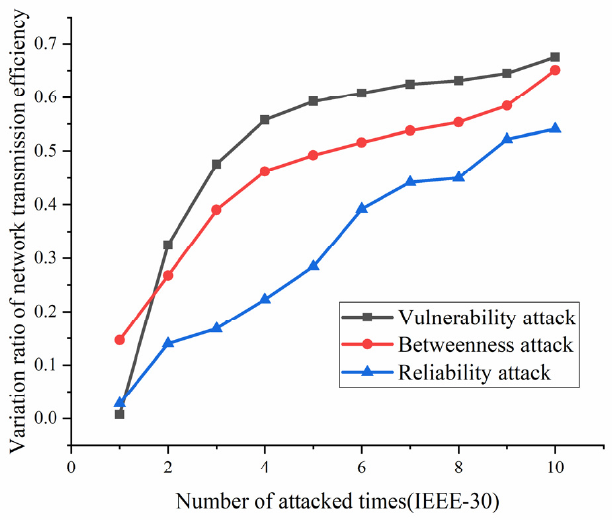
Figure 18. Variation ratio of network transmission efficiency of IEEE-30 bus system without extreme